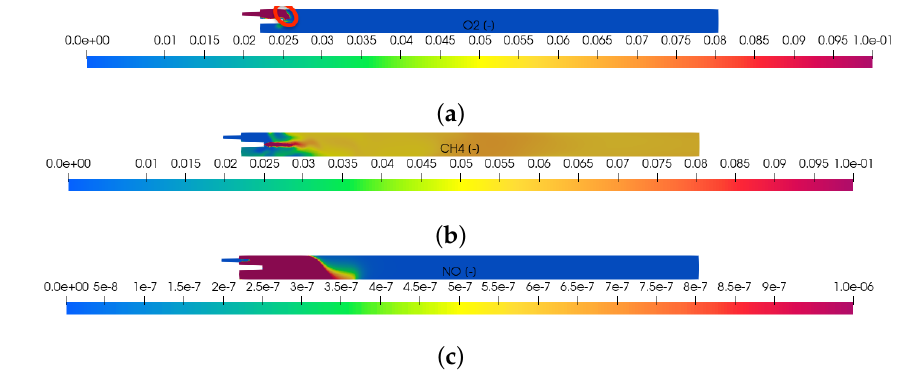
Figure 2. Mass fraction of oxygen, methane and thermal nitric oxide in the kiln along the center axial plane ( xz -plane at y = 0) after t = 60s of simulation time: ( a ) computed mass fraction of oxygen; highlighted in red at the top left is the thin reaction zone; ( b ) computed mass fraction of methane; ( c ) computed mass fraction of thermal nitric